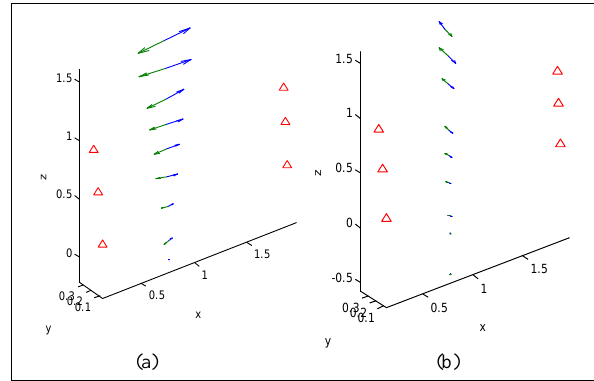
Figure 8. Captured vibration envelopes of the vertical timber as a result of excitation in the (a) X and (b) Y Figure 6. Captured vibration envelopes of the rotated model structure.